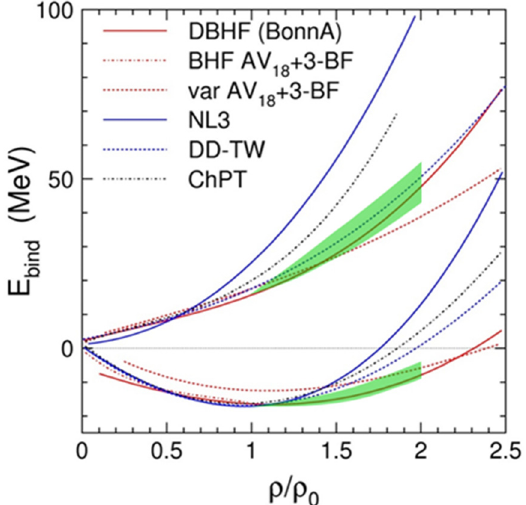
Figure 15. Binding energy as a function of nuclear matter density in units of ρ 0 . The lines represent the results of various calculations for neutron matter (upper curves) and for symmetric matter (lower curves) [62]. Lower green area: EOS for symmetric matter as extracted from data of the KaoS [54,55] and FOPI [59] experiments. Upper green area: Symmetry energy E sym as extracted from the data of the ASY–EOS experiment [61] added to the experimental EOS for symmetric matter (see text).